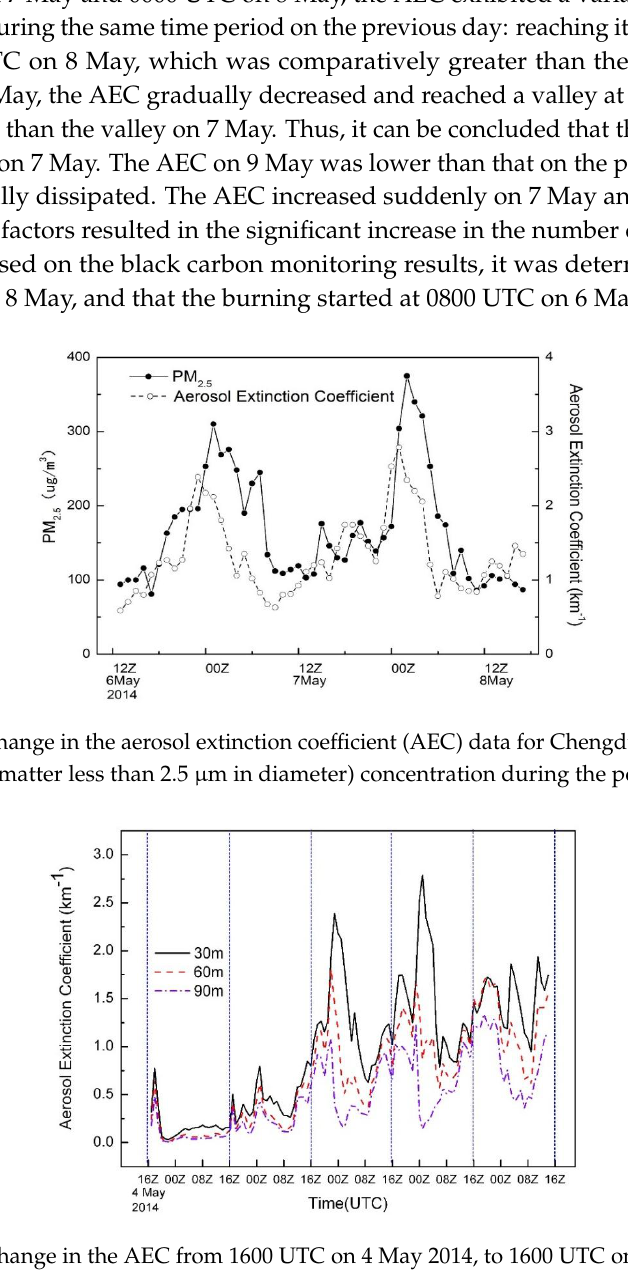
Figure 5. Hourly change in the AEC from 1600 UTC on 4 May 2014, to 1600 UTC on 9 May 2014. Note that 0000 UTC is the same 0800 local sidereal time (LST).